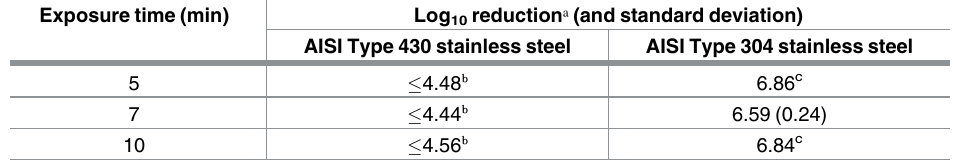
Table 2. Carrier test: Reductions of C . difficile spores by 1376 ppm peraceticacid (starting concentra- tion) at 20˚C. Exposure time (min) Log 10 reduction ᵃ (and standard